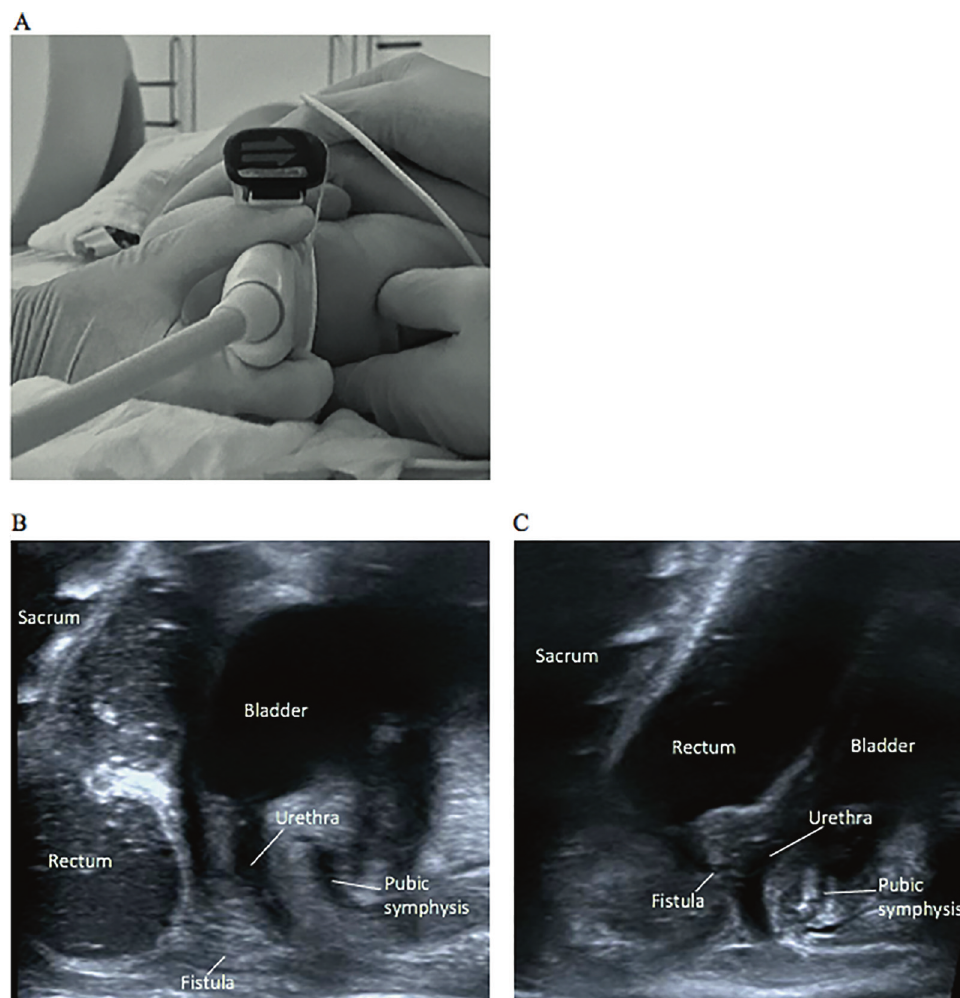
Fig. 1 High resolution perineal ultrasound images: position of the linear transducer with PIUR tUS In fi nity System add on mediansagittal at the center of the perineal body, patient supine held in lithotomy position, foley cathter in the mucous fi stula. ( A ); recto-bulbar fi stula ( B ); recto- prostatic fi stula ( C